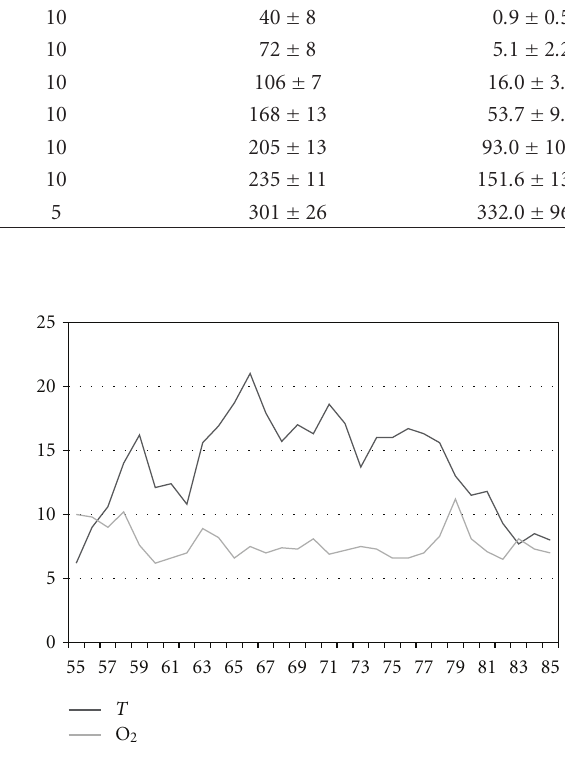
Figure 2: Water temperature ( ◦ C) and oxygen concentration (mg · l − 1 ) in 2009 (weeks